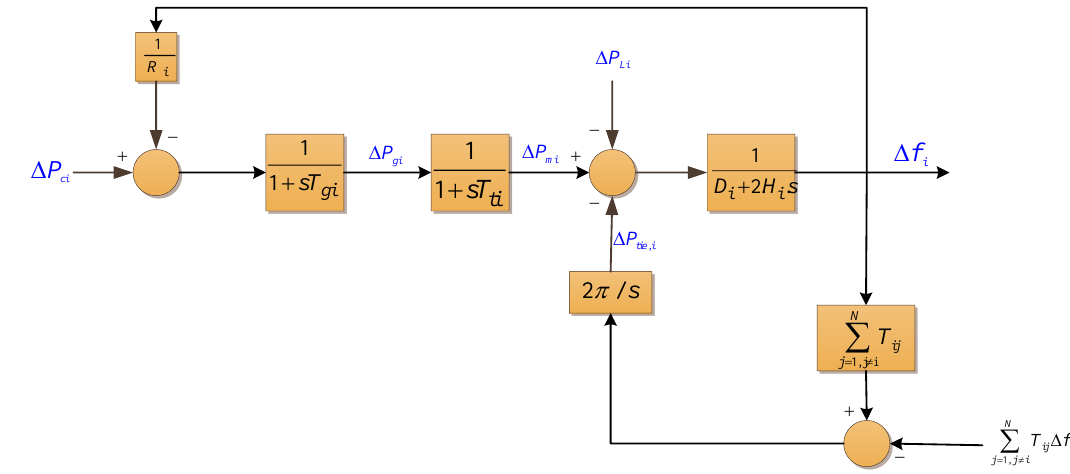
Figure 1. System frequency response (SFR) model with non-reheat